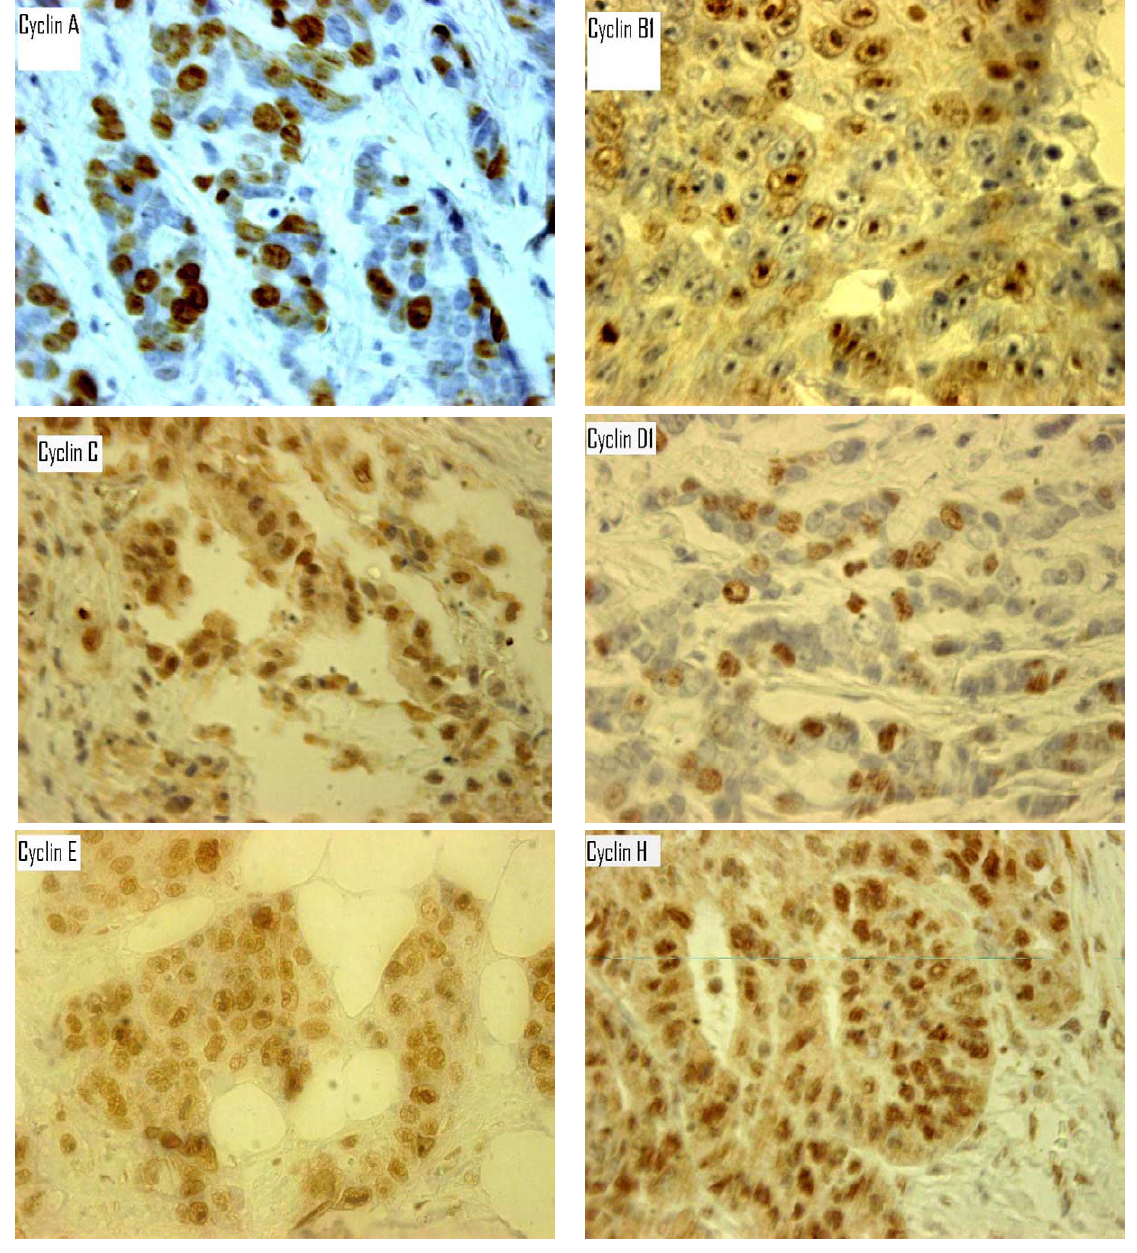
Fig. 1. Examples of immunostaining of different